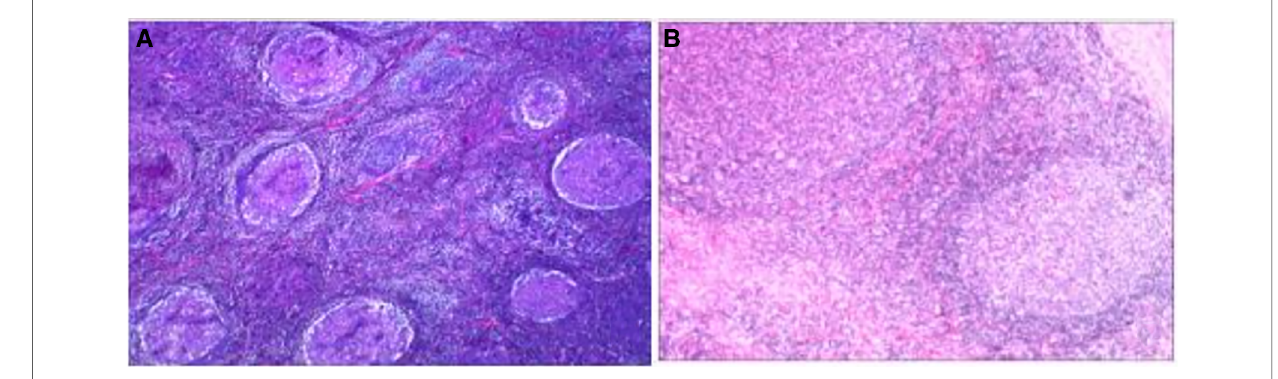
FIGURE 1 ( A ) Hyperplasia of lymphoid follicular tissue in lymph nodes. ( B ) Reactive germinal center with the obvious well-formed mantle